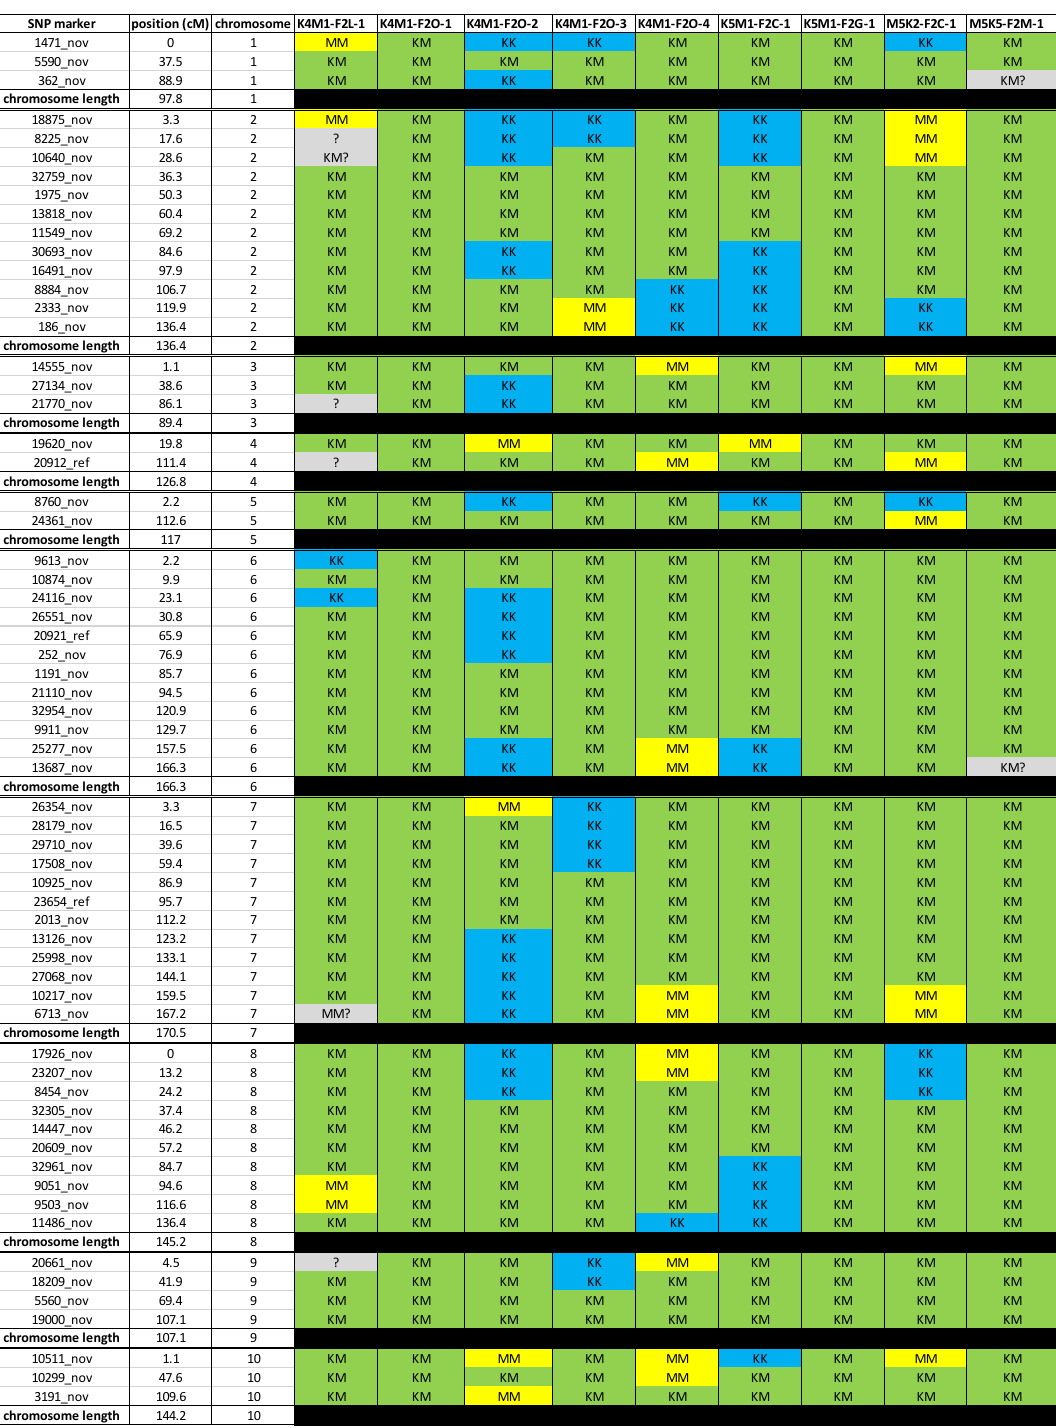
Supplementary Table 1 : Genotypes of the 9 parthenogenetic daughters of virgin heterozygous females at all the 63 SNP markers used.